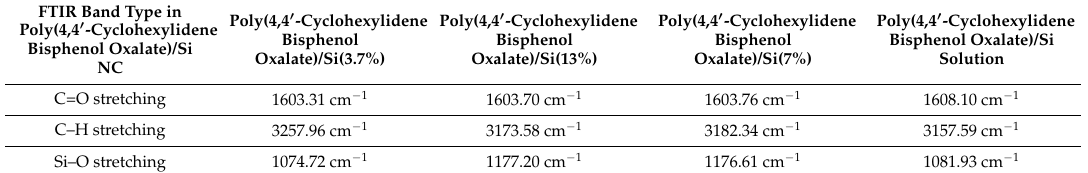
Figure 2. FTIR spectral comparison different ratios of Si in poly(4,4’-cyclohexylidene bisphenol oxalate/Si NC, with that of pure forms of poly(4,4’-cyclohexylidene bisphenol oxalate) and Si NPs. Table 3. Comparison of the FTIR spectral band positions of poly(4,4’-cyclohexylidene bisphenol oxalate)/Si NCs with different ratios of Si.